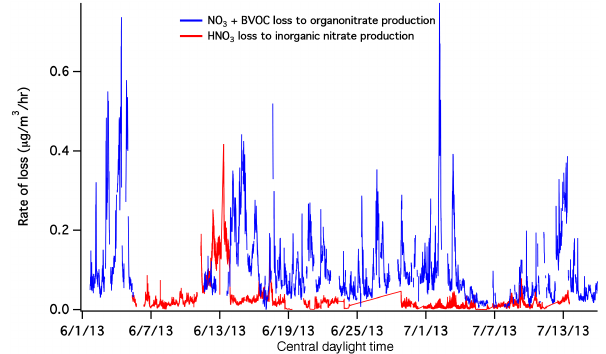
Figure 9. Over the campaign, similar magnitudes of the rate of for- mation of organic and inorganic nitrate aerosol (according to the pathways shown in Scheme 1) are observed, though peaks occur at different